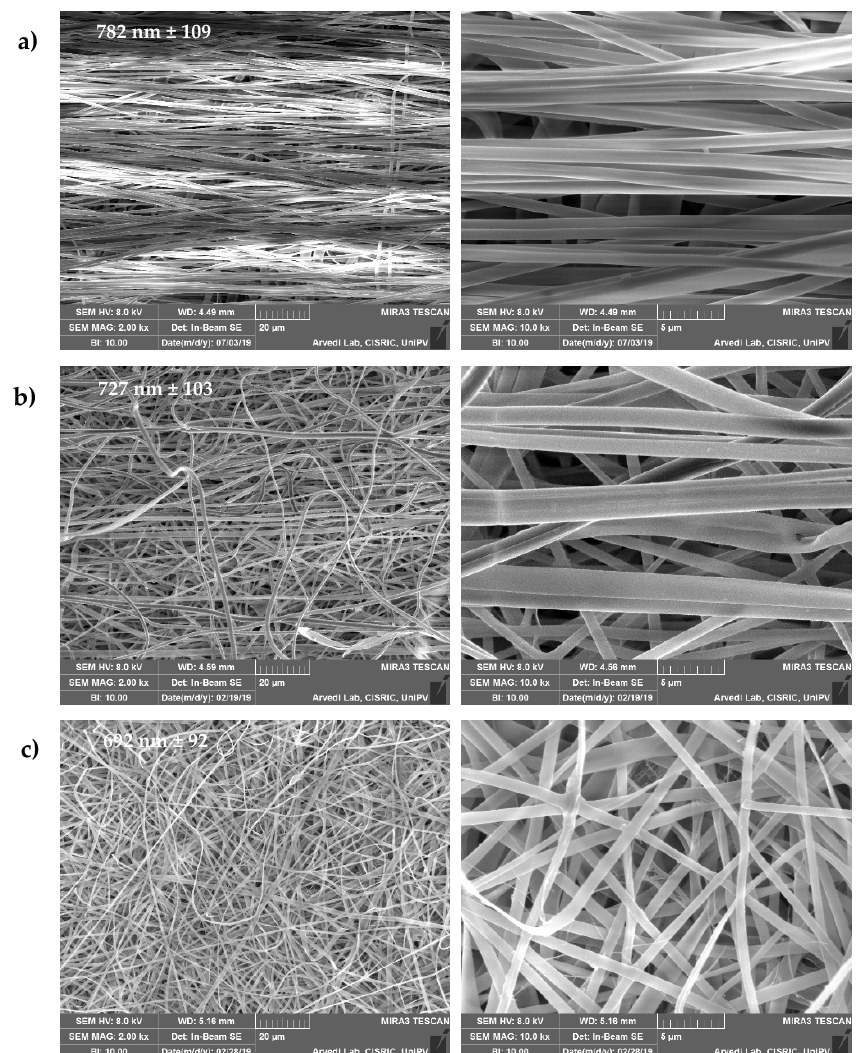
Figure 2. SEM images (2 and 10 kx, left and right panels, respectively) of the scaffold: ( a ) A-B, aligned undoped part; ( b ) interface region between the A-B and R-HAP parts; ( c ) R-HAP, random HAP doped nanofibers. In the images, the nanofiber sizes are reported (mean values ± sd; n = 8).